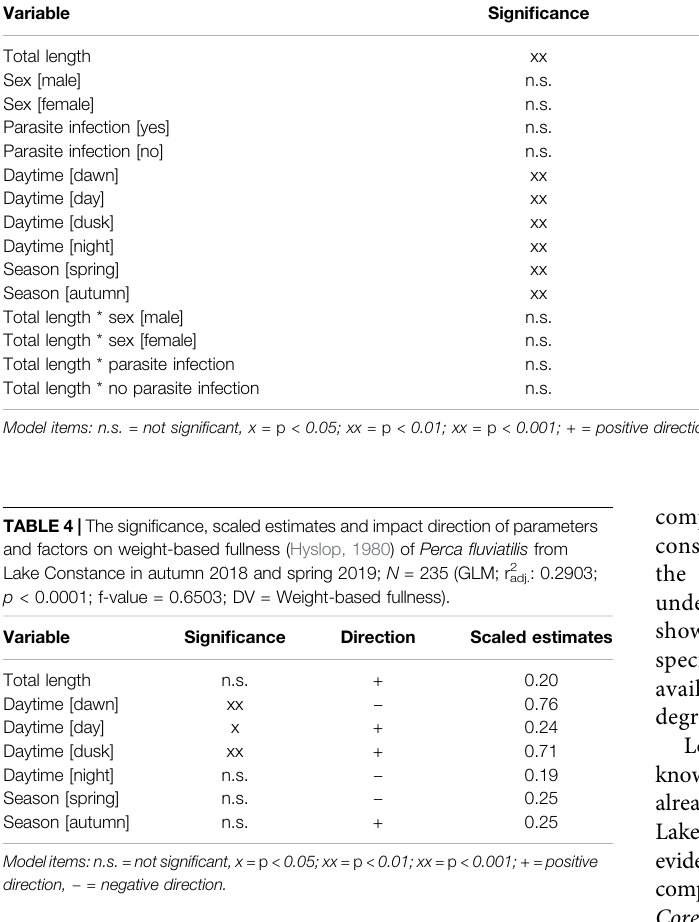
TABLE 3 | The signi fi cance, scaled estimates and impact direction ofparameters and factors on weight-based fullness (Hyslop, 1980) of Gasterosteus aculeatus from Lake Constance in autumn 2018 and spring 2019; N (cid:2) 280 (GLM; r 2 adj. : 0.7332; p < 0.0001; f-value (cid:2) 0.9455; DV (cid:2) Weight-based fullness). Variable